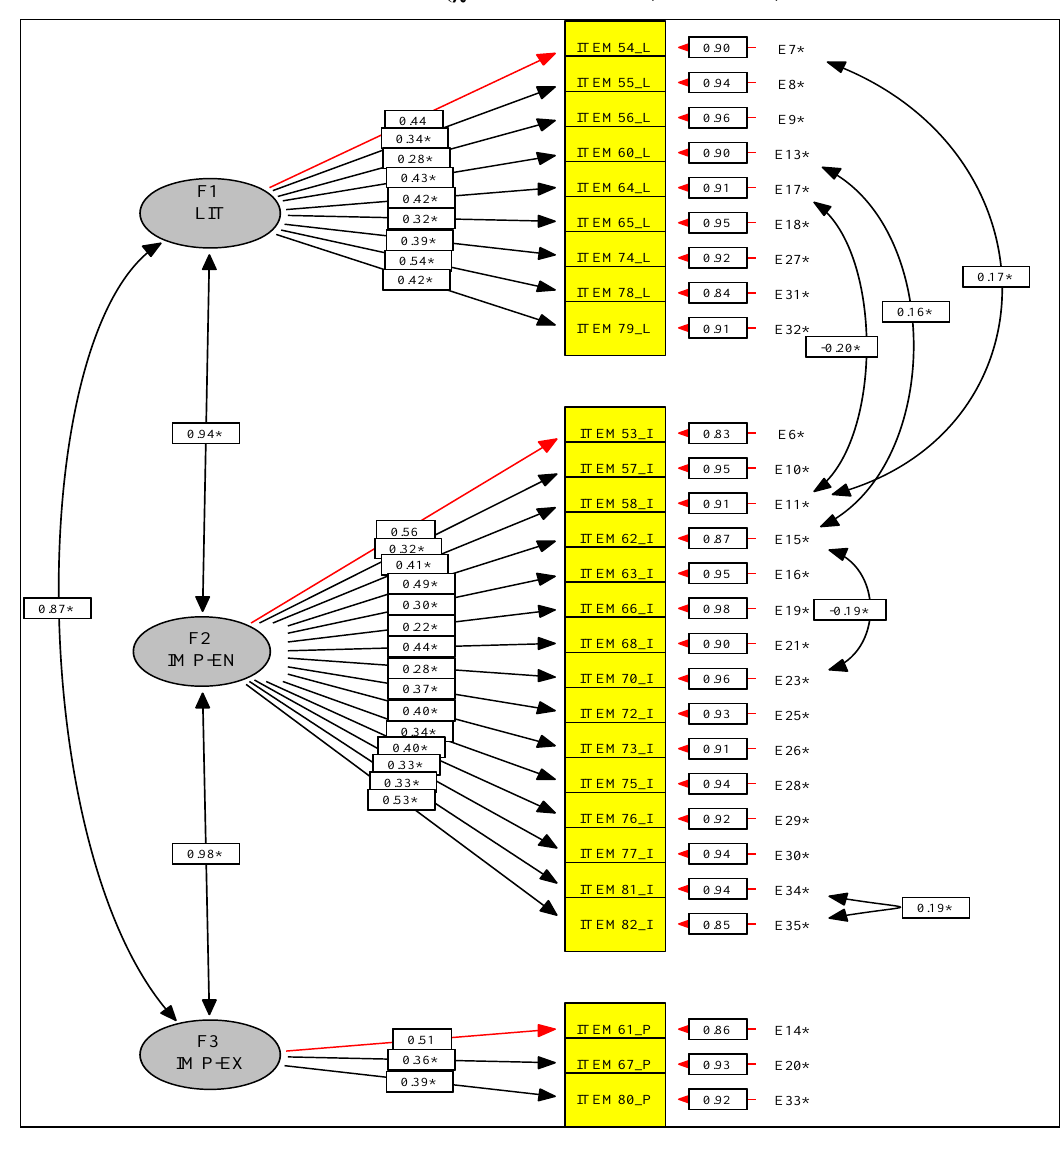
Modified 3-factor Model (χ 2 /df ratio:1.128; CFI:.951;